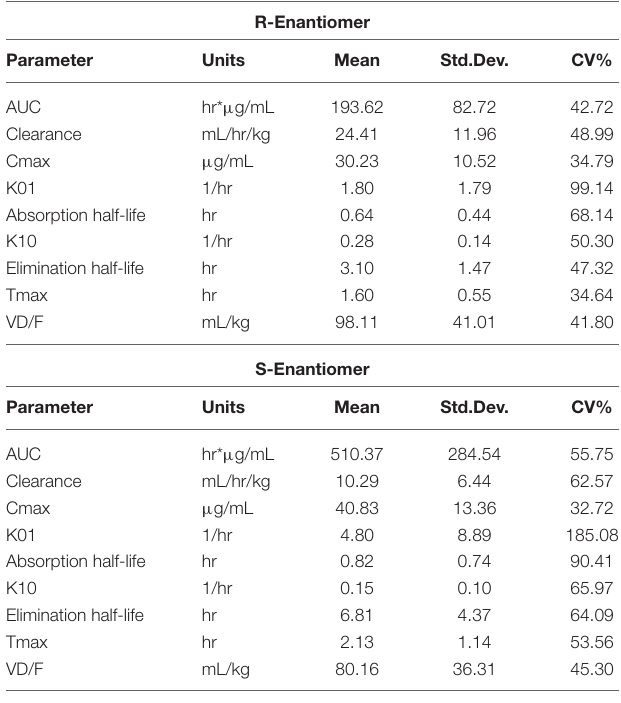
TABLE 2 | Summarized data after an 8 mg/kg intramuscular (IM) injection in Nile tilapia ( Oreochromis niloticus